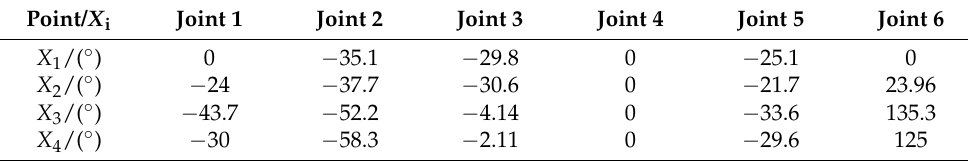
Table 2. Interpolation points of the joints.